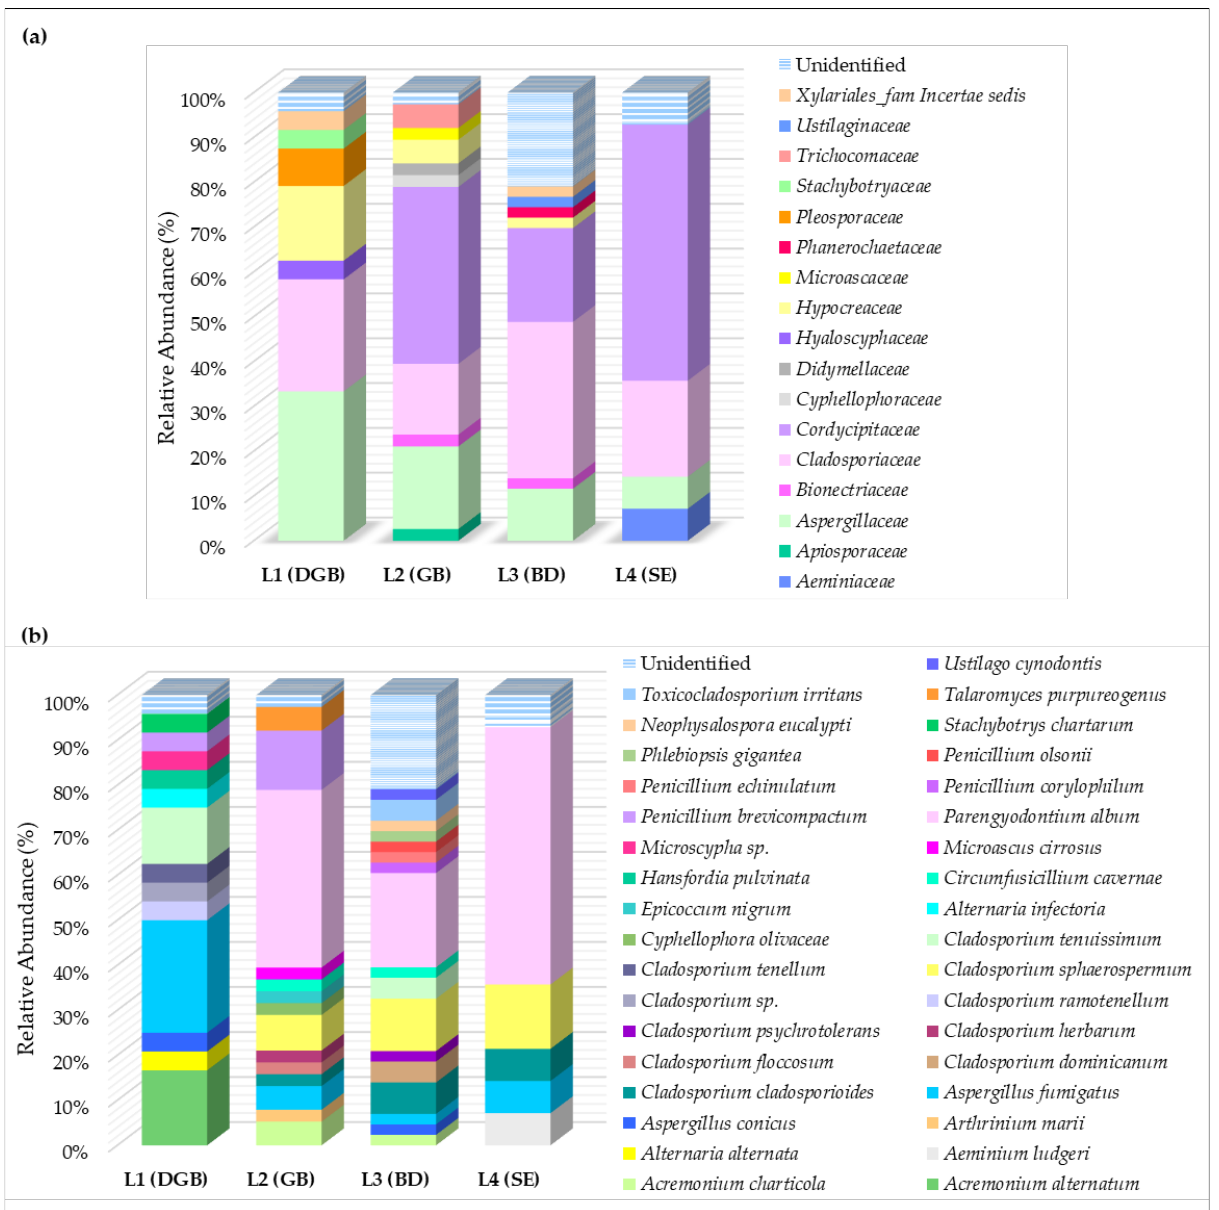
Figure 8. Relative abundance of the cultivable fungal diversity of all four sampling sites at ( a ) family level and ( b ) species level.